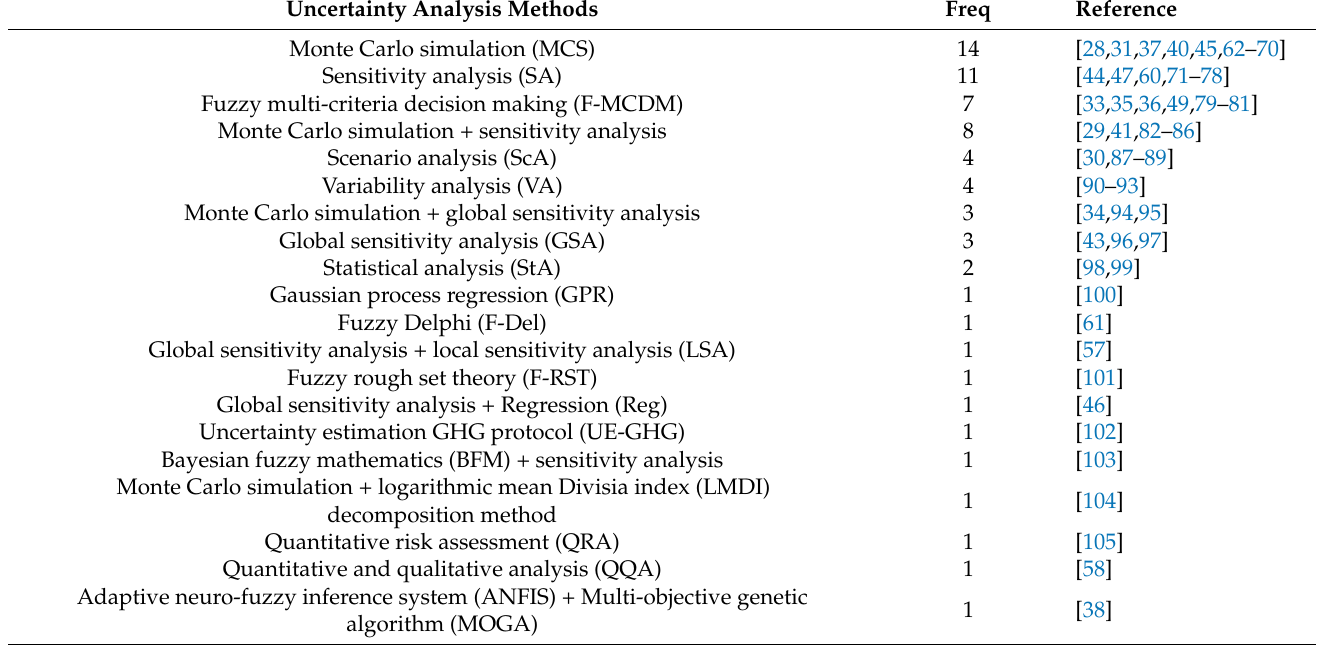
Table 5. Uncertainty and sensitivity analysis